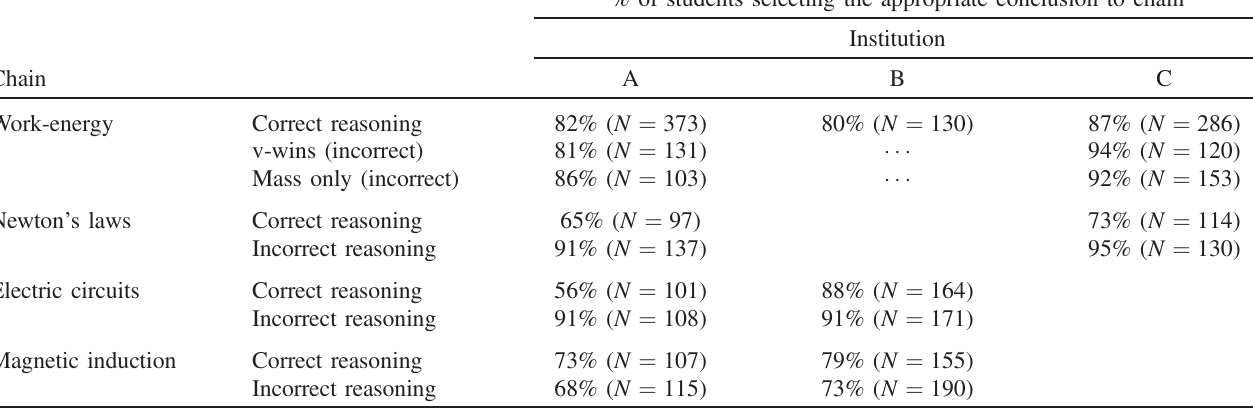
TABLE II. Average percentage of students who selected the appropriate conclusion when presented with a particular chain, at each institution. Note that students were randomly served only one of the possible reasoning chains, thus each entry in the table represents a distinct group of students. In some cases, data from multiple semesters and lecture sections have been combined. Not all tasks were administered at each institution. Students who did not provide reasoning when responding to the question posed in the base task were omitted from this